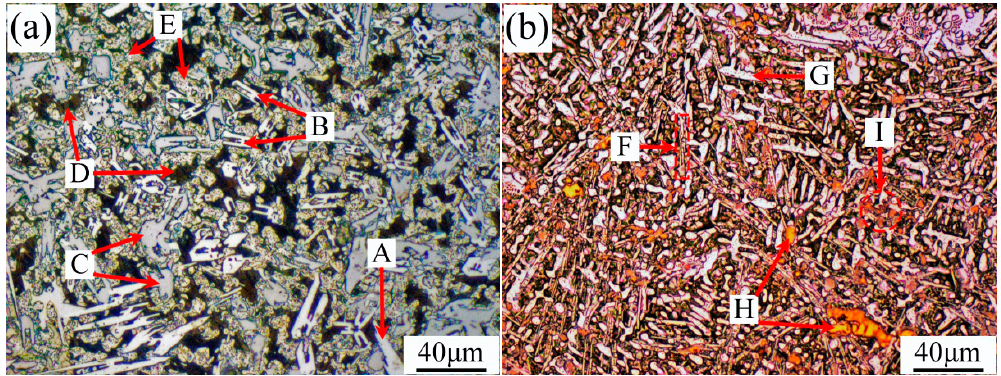
Figure 8. Top coating microstructures of specimens ( a ) No.1 and ( b ) No.2.